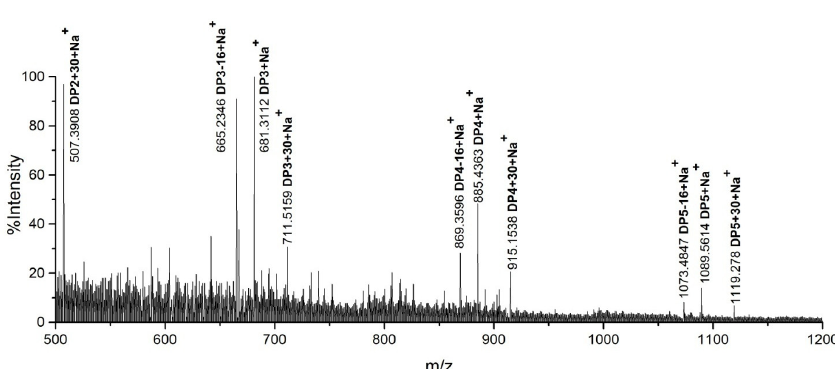
Figure 3. Identification of n Ta AA9A permethylated reaction products using MALDI–TOF MS. n Ta AA9A reaction products upon incubation of 0.5% PASC with n Ta AA9A in 10 mM HOAc–NH 4 OAc (pH 5.0) and 1 mM ascorbate at 50 °C for 48 h, followed by permethylation with methyl iodide. C1-oxidized oligosaccharides ( m / z +30), C4-oxidized oligosaccharides ( m / z − 16), and non-oxidized oligosaccharides ( m / z +0).